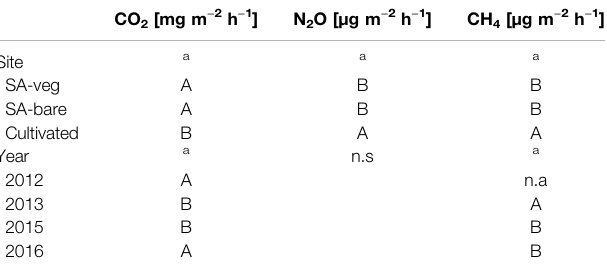
TABLE 4 | Season-speci fi c average plant-derived carbon dioxide (CO 2 ) fl ux [mg m − 2 h − 1 ] at the set-aside site in seasons covered by manual measurements in 2012 and 2015.